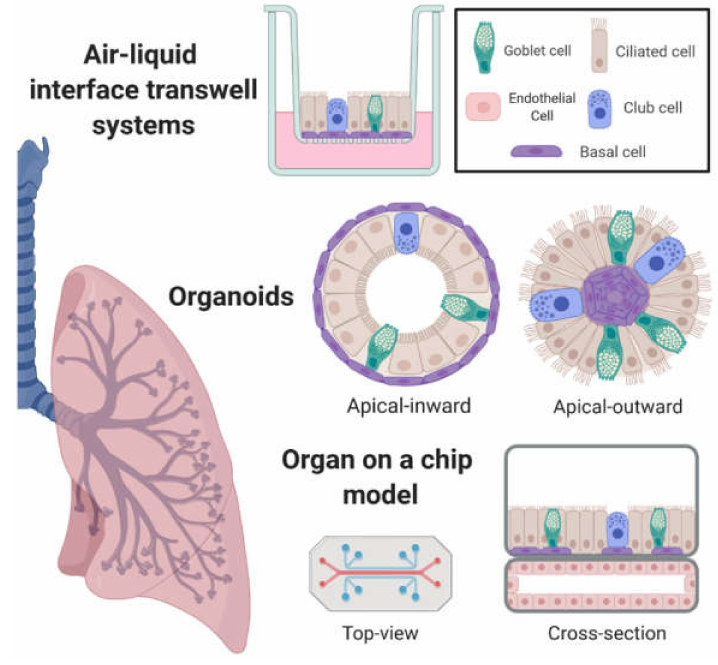
Figure 1. In vitro model systems of the human respiratory tract with emergent properties. Air liquid interface (ALI) systems utilize porous membranes for cell attachment, giving rise to consistent open-air lumen development. Organoid systems self-organize within a matrix or sca ff old, often leading to variable orientations of the lumen. Organ on-a-chip models utilize multiple tissue lineages on a mechanically manipulated sca ff old, capturing dynamic tissue–tissue interactions. Created with